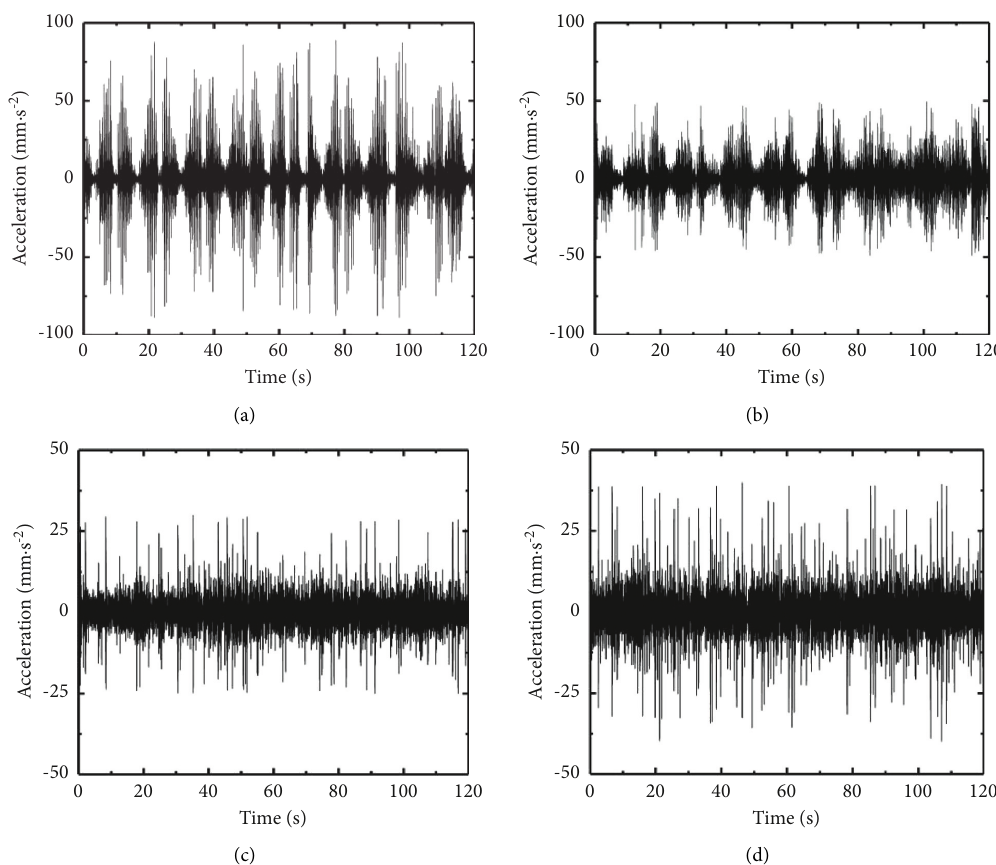
Figure 9: The time-history curves under different walking conditions. (a) Single walking. (b) Pair walking. (c) 24 people walking. (d) 56 people walking.